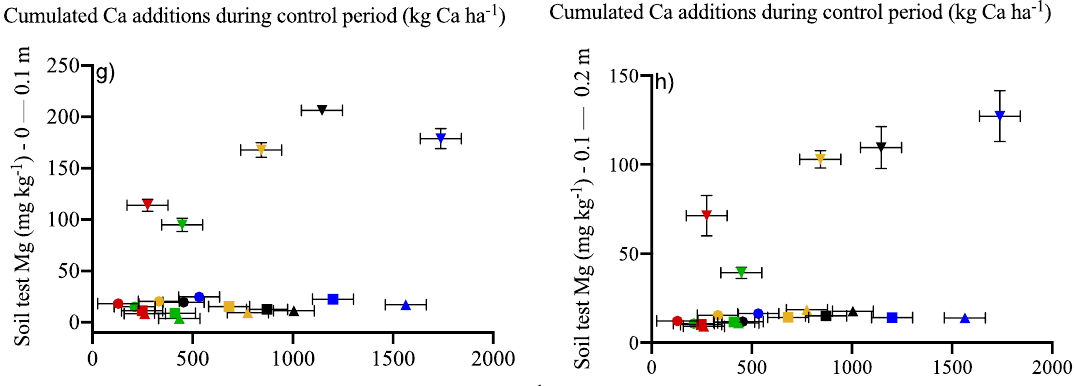
Figure 3. Change in soil P ( a , b ), K ( c , d ), Ca ( e , f ), and Mg ( g , h ) during the 2009–2020 period in the 0–0.1 and 0.1–0.2 m layers, respectively, as impacted by treatments. Error bars represent standard errors of the